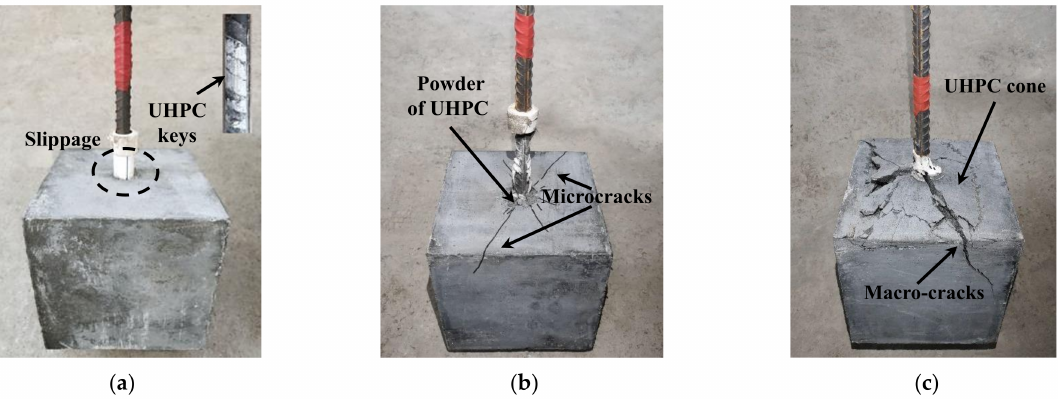
Figure 6. Typical failure modes: ( a ) pull-out failure; ( b ) splitting + pull-out failure; ( c ) cone failure. For the traditional loading specimens, the ribs of the tensile rebar cut the UHPC